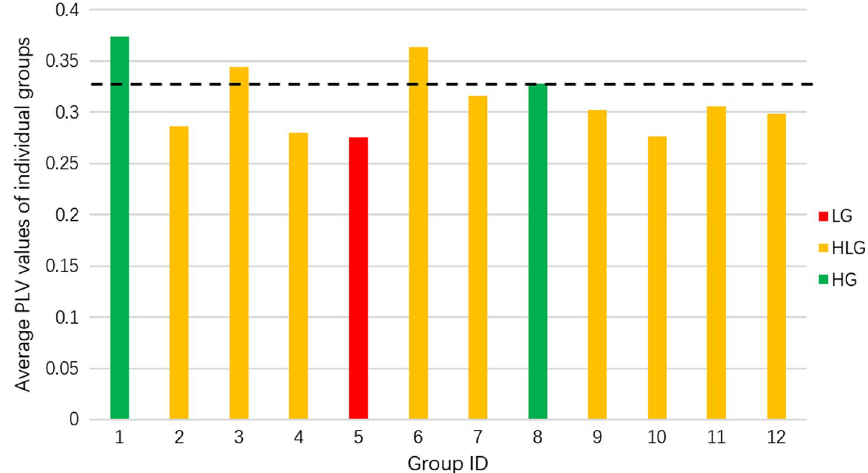
Fig. 2 The mean of PLV values of high gamma bands at the problem‑understanding